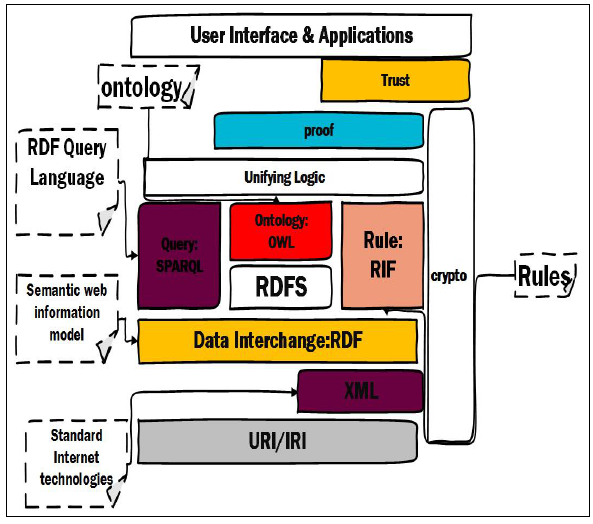
Figure 2. Semantic Web Stack